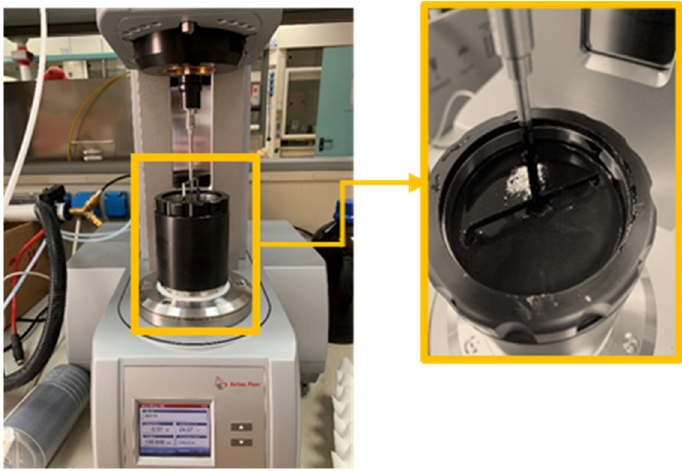
Figure 3. Building material cell equipment (Anton Paar, Graz, Austria) for mixing mastics.